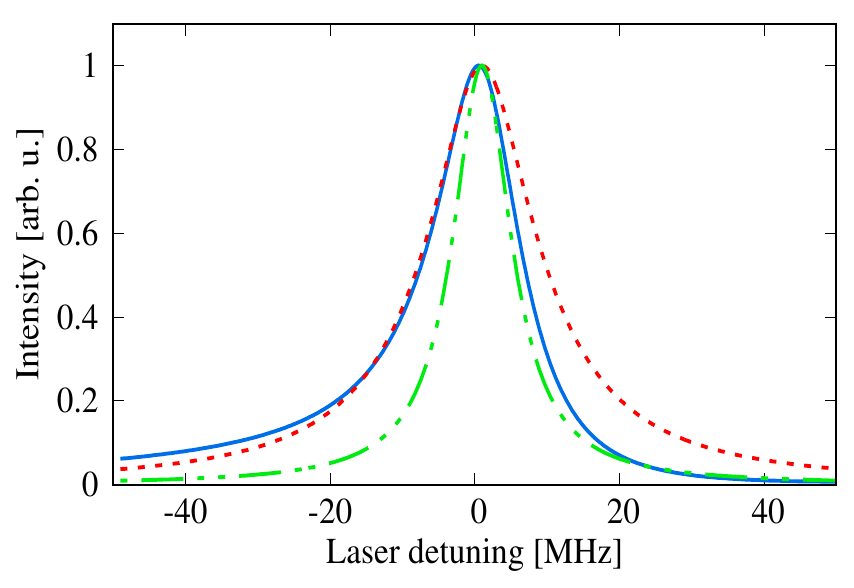
Figure 5. The same as in Figure 4 in the case of D 2-line of sub-thermal Na atoms and the excitation of the closed F (cid:48)(cid:48) = 2 → F (cid:48) = 3 transition with laser Rabi frequency Ω = 21.2